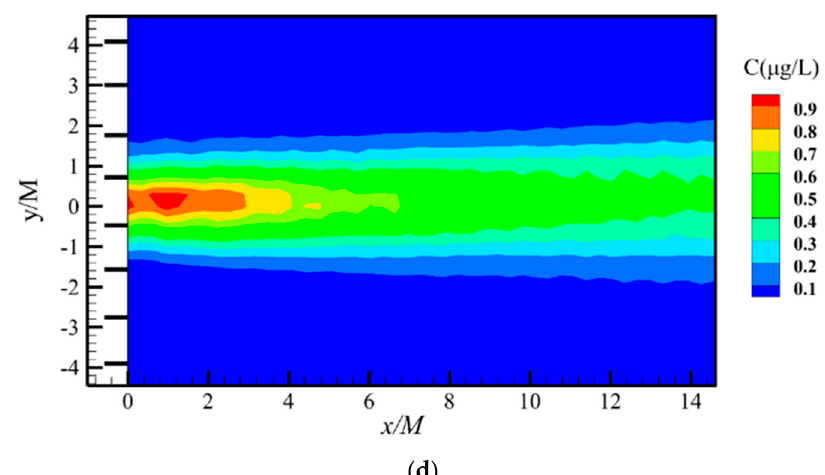
Figure 2. Time-averaged ( a ) velocity field and ( b ) concentration field downstream of net on the horizontal center plane for the case C1, and ( c ) velocity field and ( d ) concentration field downstream of net on the horizontal center plane for the experimental case X2 in Zeng et al. [8] .